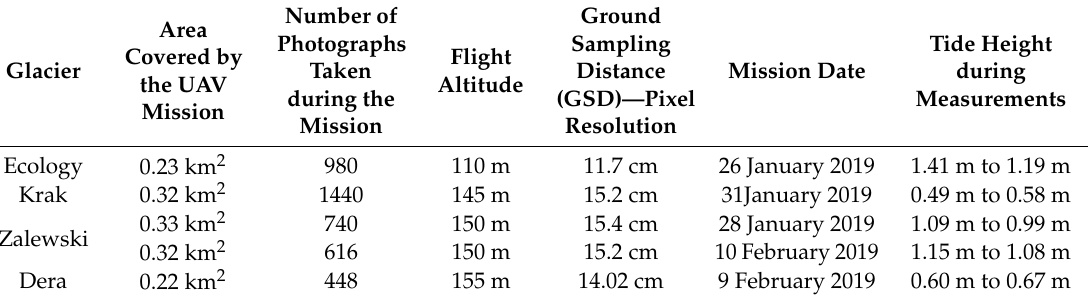
Table 2. Flight specifications (Parrot Sequoia + ).